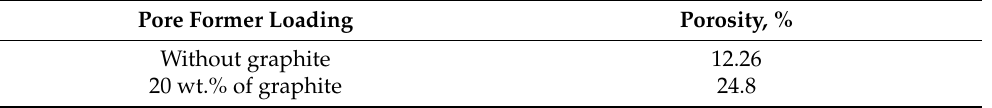
amount of graphite pore